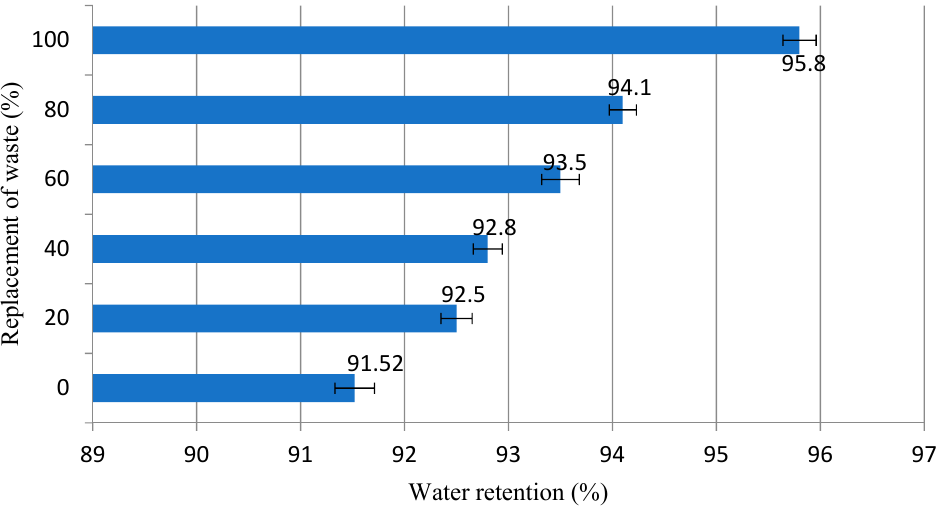
Figure 7. Result of water retention (%) of evaluated mortars.